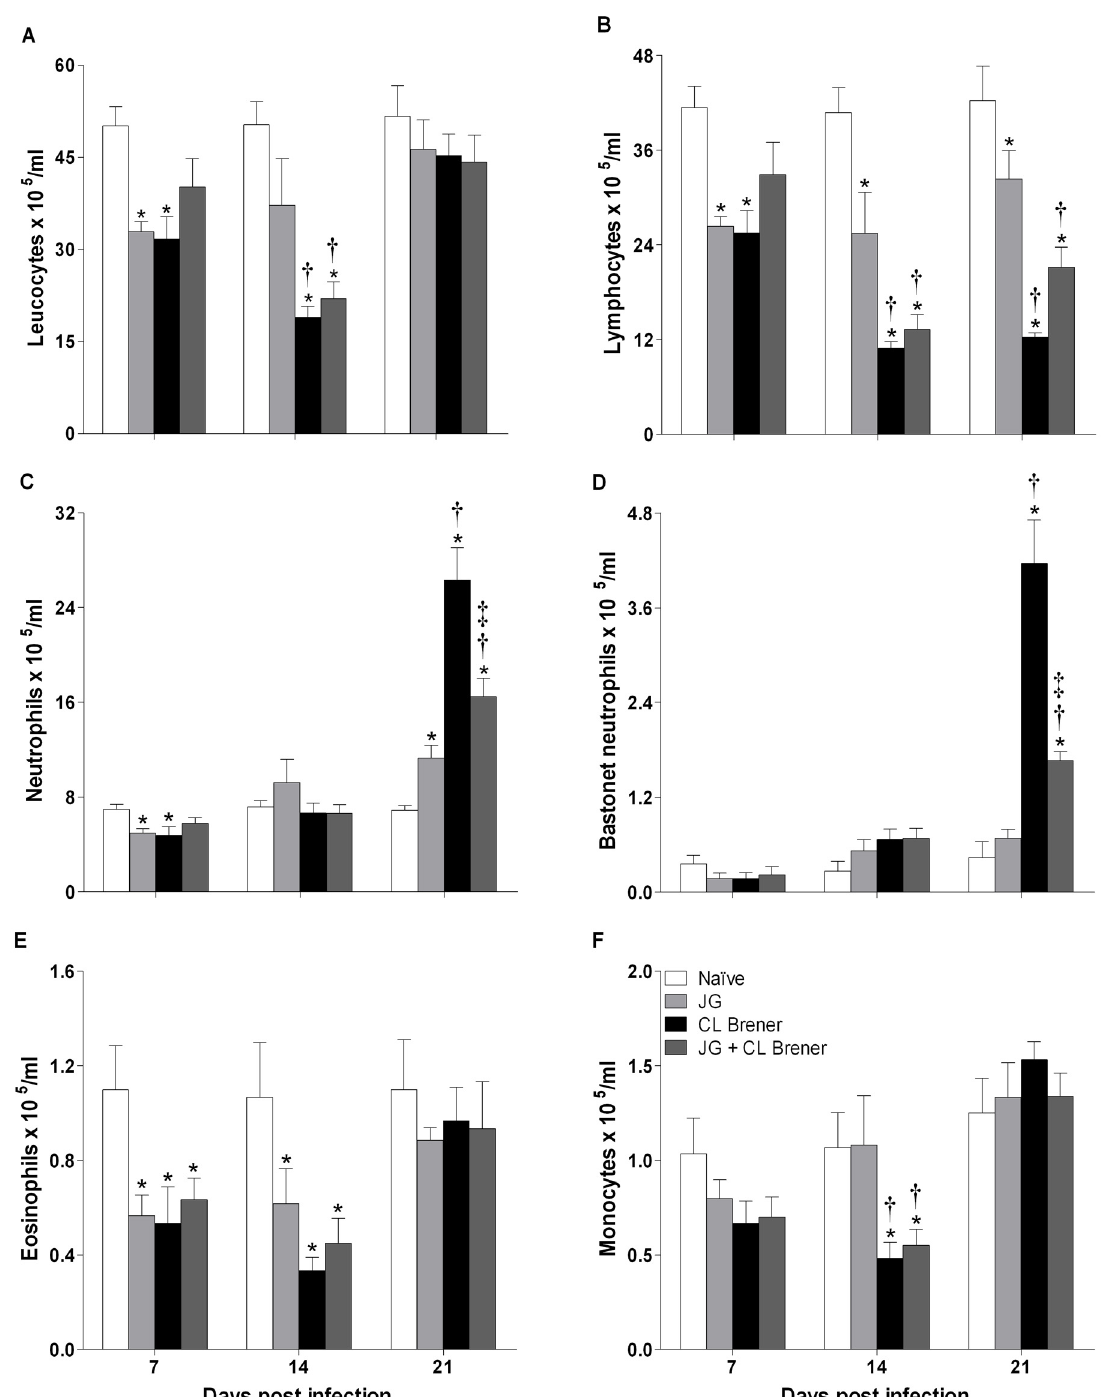
Figure 3. Total and differential blood leukocyte counts from BALB/c mice infected with JG and/or CL Brener. Groups of mice were infected with 100 trypomastigotes of JG or CL Brener (single infection) or coinfected with 100 trypomastigotes of both T. cruzi populations in a 1:1 ratio via the intraperitoneal route, and blood leukocyte counts were assessed at 7, 14 and 21 days p.i. Symbols as follows: (A) leucocytes; (B) lymphocytes; (C) neutrophils; (D) bastonet neutrophils; (E) eosinophils; (F) monocytes; white bar: Naı¨ve mice; light gray bar: JG infected mice; black bar: CL Brener infected mice; and dark gray bar: JG and CL Brener infected mice. Values are expressed as the mean 6 SEM of three mice per group (representative of two independent experiments). *, { and { represent P , 0.05 when compared with naı¨ve, JG and CL Brener mouse groups, respectively.